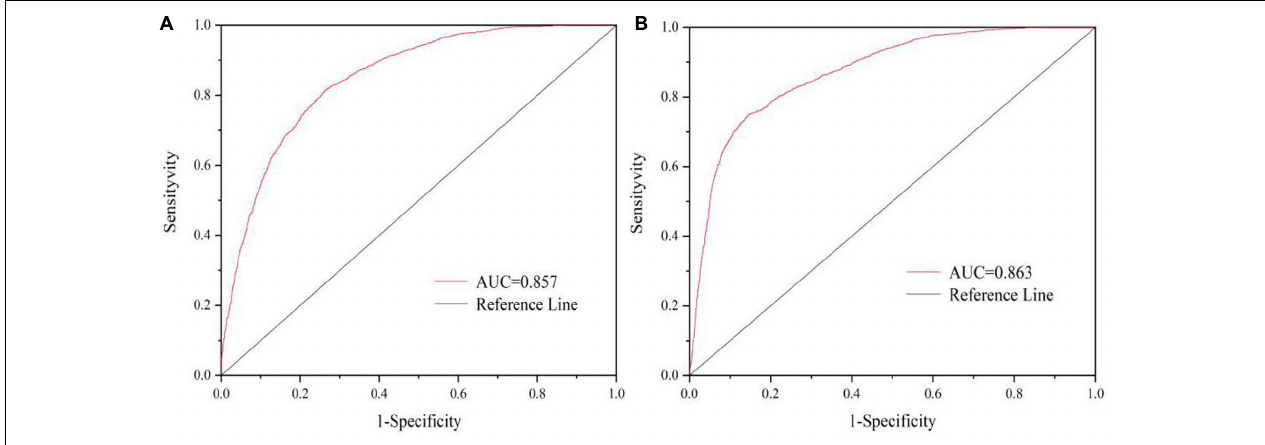
FIGURE 5 | Receiver operating characteristic (ROC) curve of the information value (IV)-based logistic regression (LR) modeling results: (A) with main linear features and (B) with complete linear